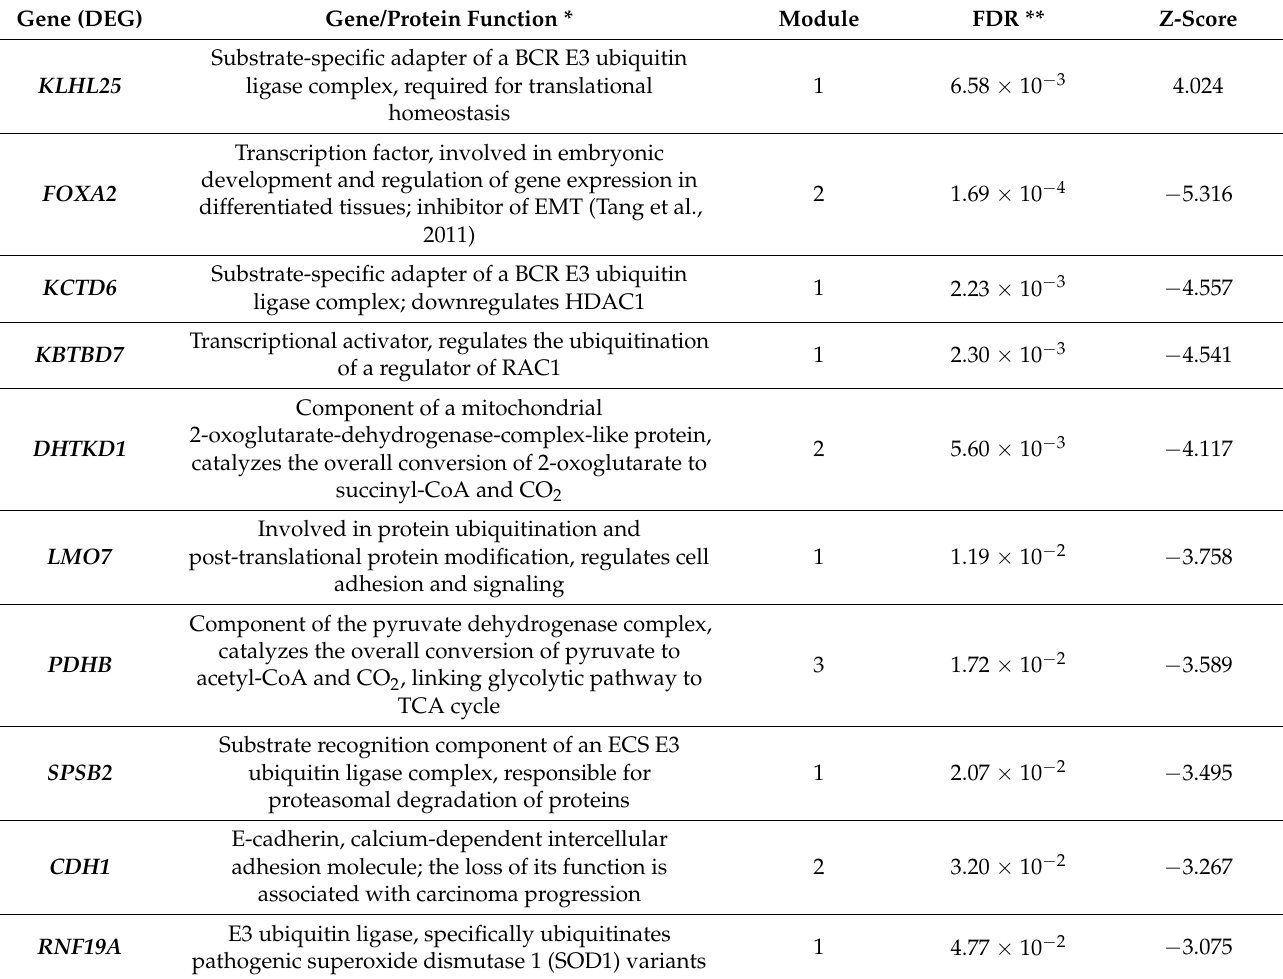
Table 2. Prognostic gene biomarkers in NSCLC, ranked according to their